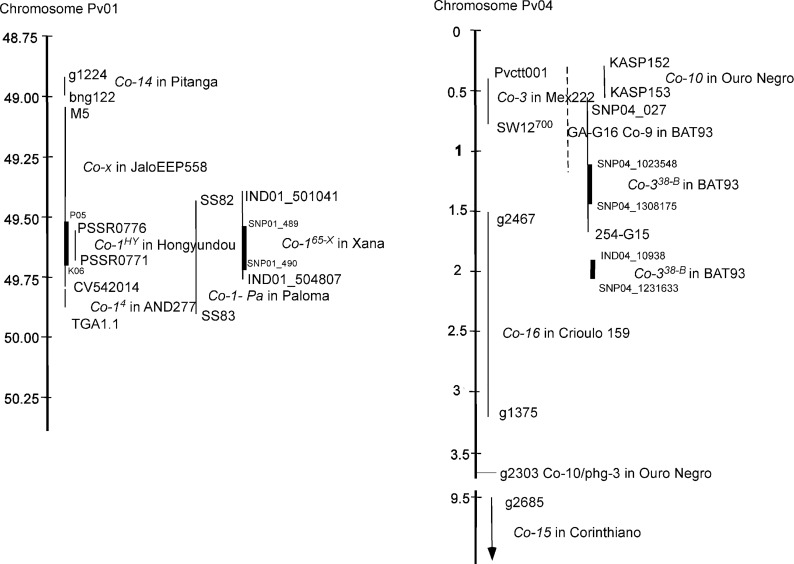
Representation of physical positions (Mb) deduced from the flanking markers for the Co- genes mapped in the end of bean chromosome Pv01 (left) and in the beginning of the chromosome Pv04 (right). Physical distance is millions of base pairs (Mb) and alignments were performed using the bean genome V2.1 (www.phytozome.net). Thick bar indicates physical delimited regions from XB RIL map. See S1 Table too. Gene Co-9 was renamed as Co-33 and Co-10 as Co-34 (http://arsftfbean.uprm.edu/bic/wp-content/uploads/2018/04/Bean_Genes_List_2017.pdf).